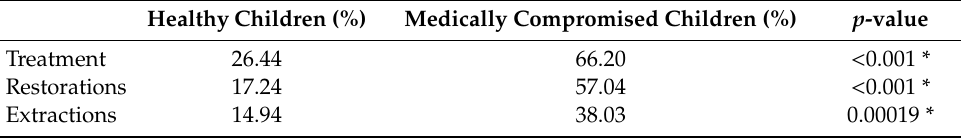
Table 3. The percentage permanent dentition treatment